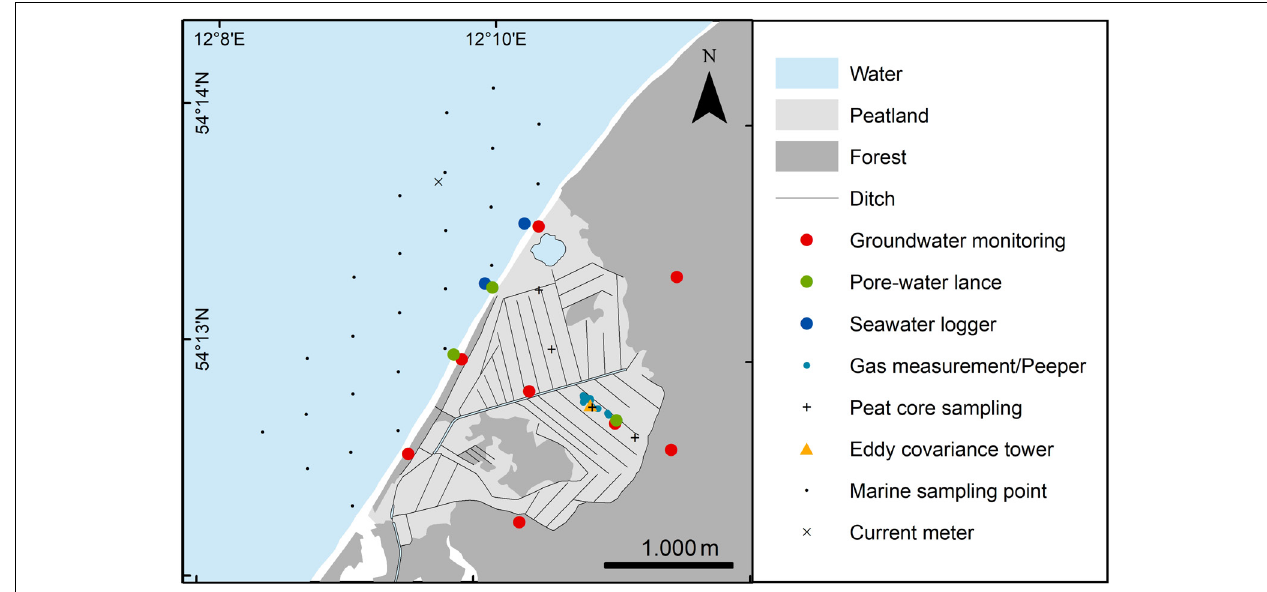
FIGURE 3 | Map of study site ‘NSG Heiligensee und Hütelmoor’ with instrumentation.